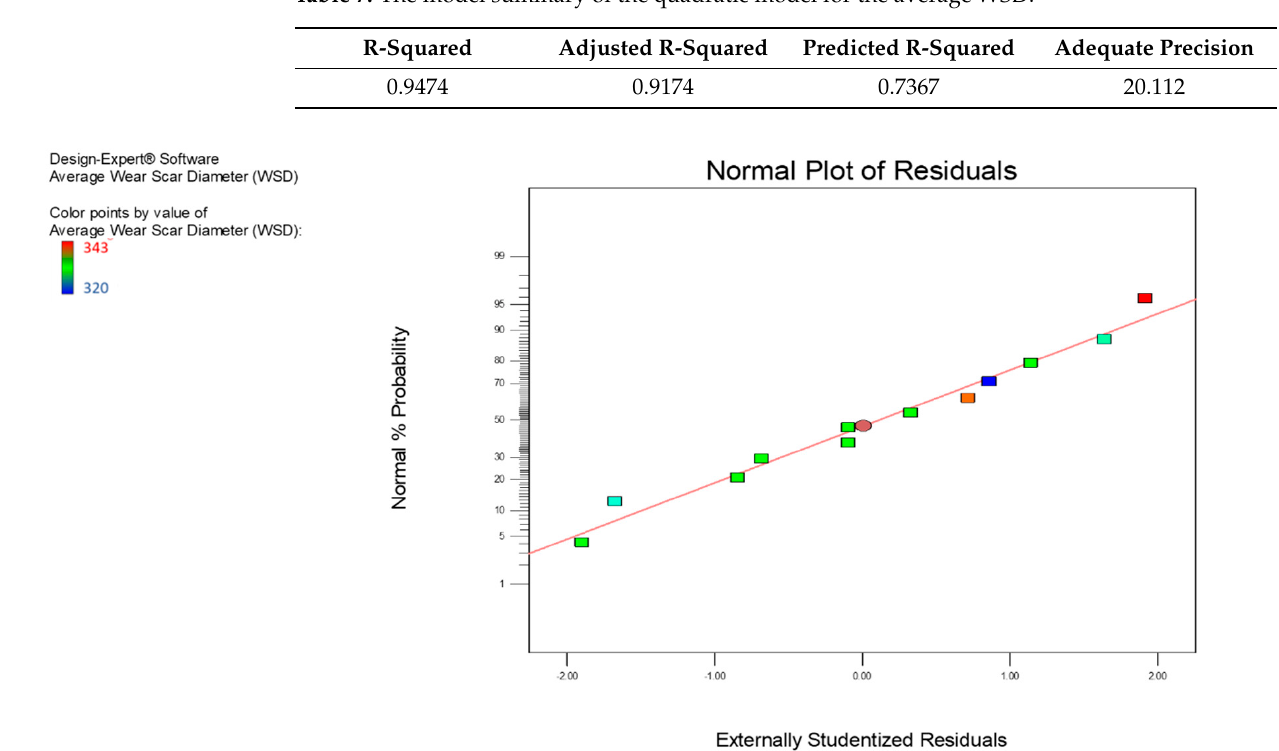
Figure 8. The normal probability plot of the average WSD for the MoS 2 nanolubricants. The interaction between various times and temperatures on the average WSD for the MoS 2 nanolubricants was examined and demonstrated using 3D response surface and contour plots. From the quadratic model mentioned earlier (Equations (6) and (7)), the surface response and contour charts showed the interaction effect of the average WSD of the MoS 2 nanolubricants in Figures 9 and 10. The required time and temperature selection for the advanced microwave synthesis of MoS 2 are crucial in this analysis to determine the average WSD for nanolubricants. It is clear from Figures 9 and 10 that the increase in the synthesis time and temperature contributed to a lower average WSD for the MoS 2